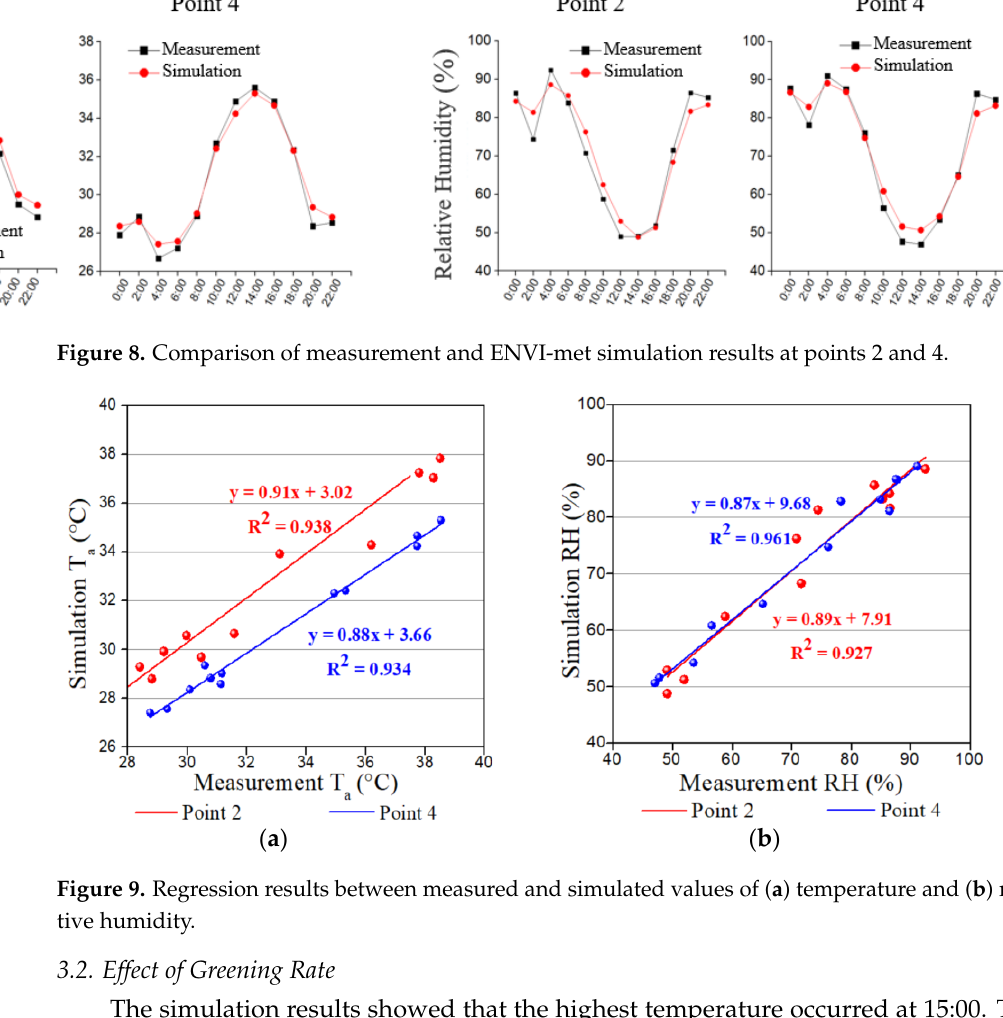
( d ) Figure 7. Results of the thermography carried out at 12:00. ( a ) Point 1; ( b ) Point 2; ( c ) Point 3; (d) ground. 3.1.2. ENVI-Met Model Validation